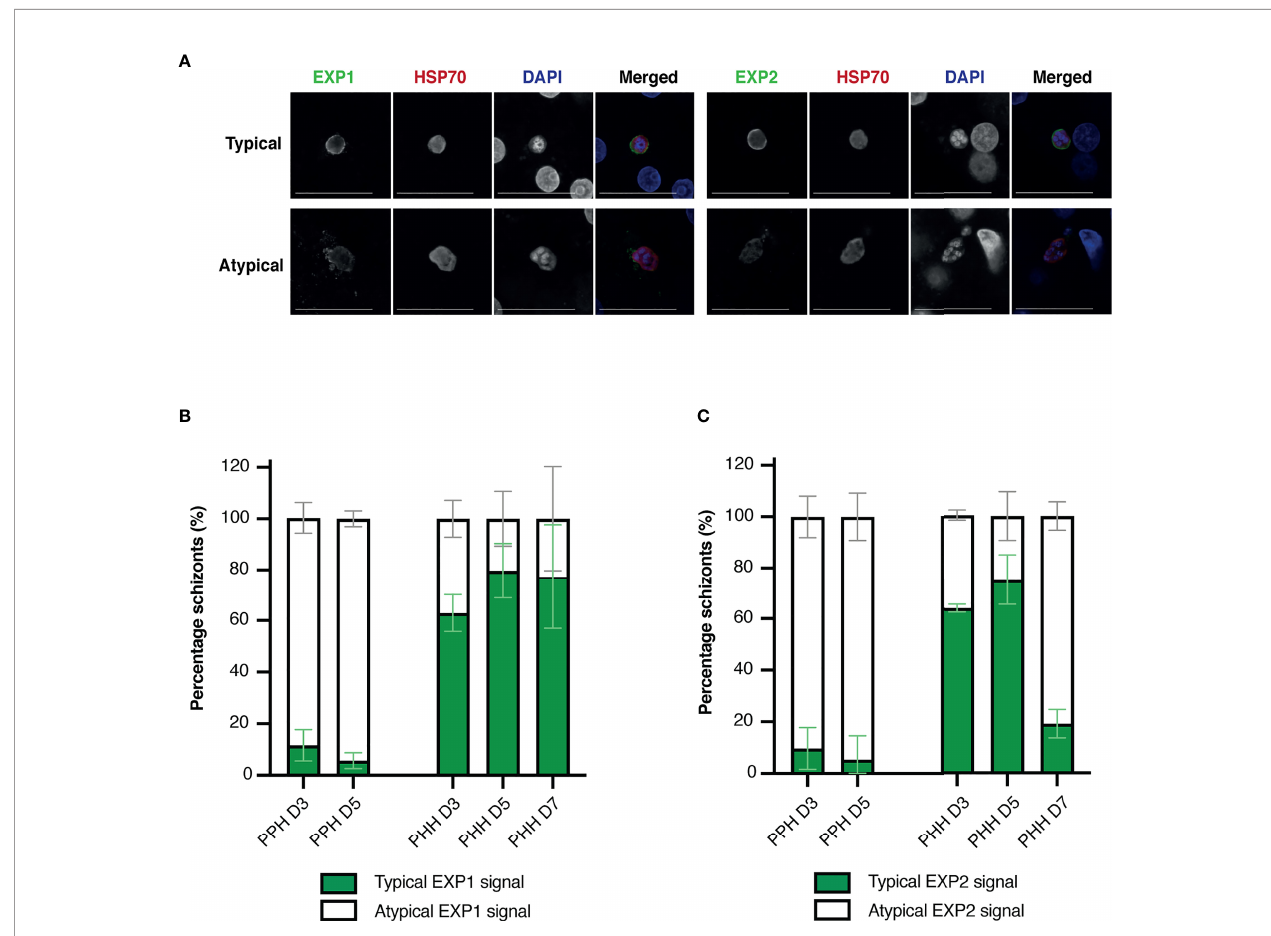
FIGURE 4 | (A) Representative immuno fl uorescence images of typical liver stage protein markers visualized through confocal microscopy including EXP1 and EXP2, HSP70, and DAPI, classi fi ed as a typical (top) or atypical (bottom) staining pattern. Images shown were obtained from infected porcine hepatocytes. Objective 63×; zoom 2×; scale bar 25 µm. (B, C) Mean percentage of human and porcine schizonts with a typical or atypical EXP1(B) or EXP2 (C) staining pattern. Porcine hepatocytes are depicted on the left and human hepatocytes on the right of each bar plot. All or up to seventy- fi ve schizonts were measured per technical replicate of three biological replicates. Results per biological replicate are shown in Supplementary Figure 4 . For panels B and C, the total number of schizonts analyzed per condition is shown in Supplementary Table 2 . EXP, exported protein; HSP, heat shock protein; PHH, primary human hepatocytes; PPH, primary porcine